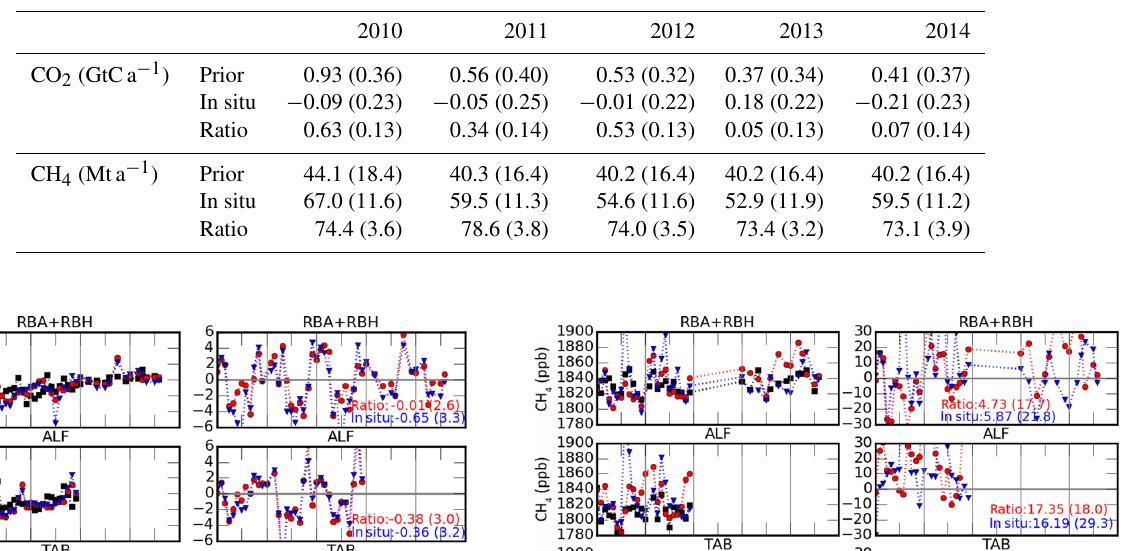
Table 3. The same as Table 1 but for CH 4 and CO 2 fluxes over tropical South America.